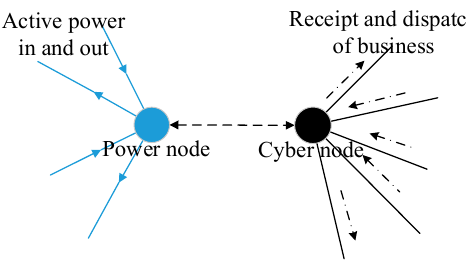
Figure 1. The active-business degree